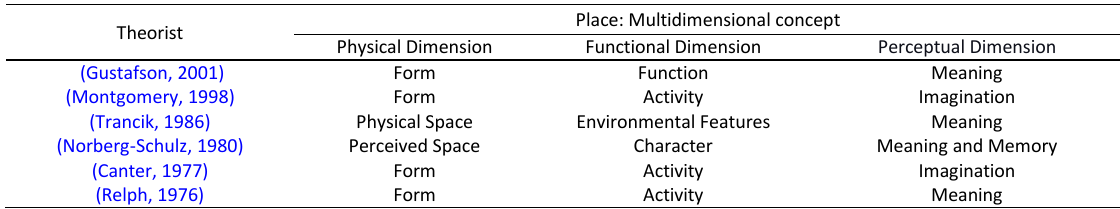
Table 1: Theorists perspectives in terms of multidimensional structure of the